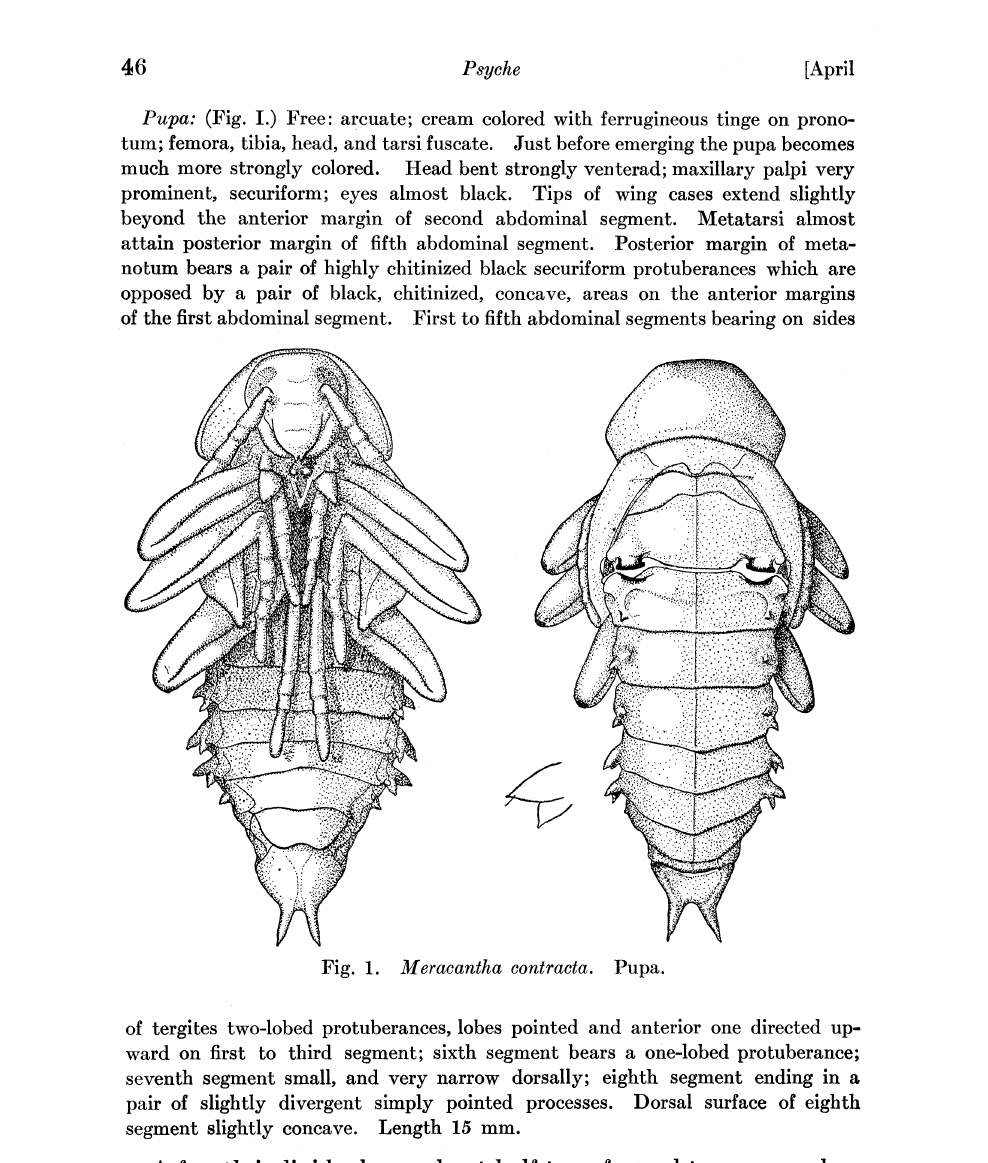
Pupa: (Fig. I.) Free: arcuate; cream colored with ferrugineous tinge on prono- turn; femora, tibia, head, and tarsi fuscate. Just before emerging the pupa becomes much more strongly colored.